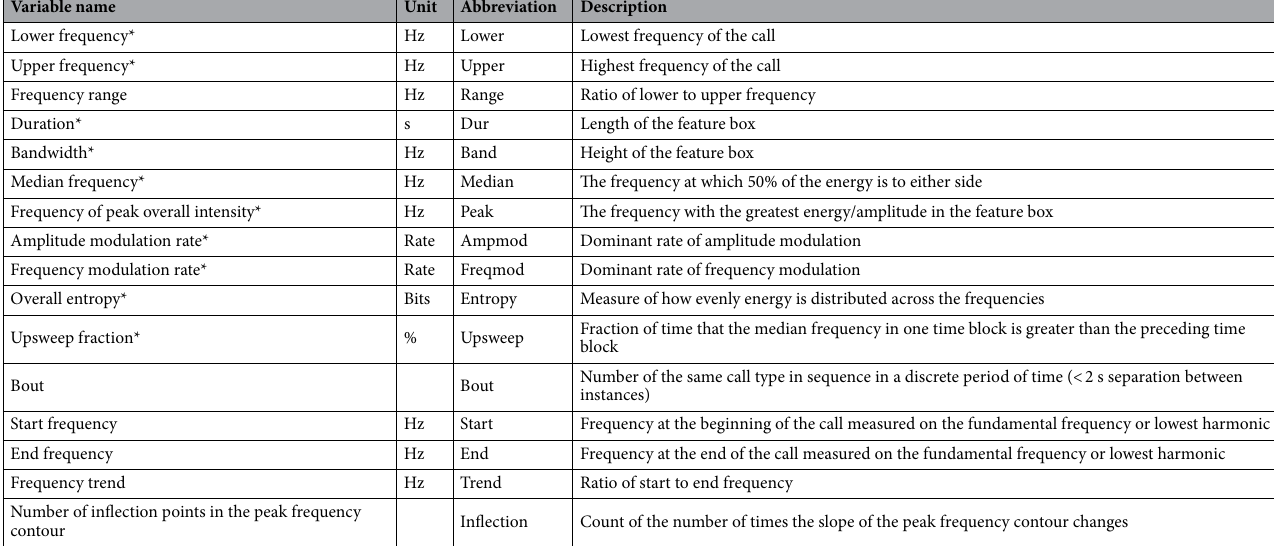
Table 4. Descriptions of the variables that were used in the CART and RF. Variables marked with a * were measured using the Noise-Resistance Feature Set (the same descriptions as for the program Osprey from Mellinger and Bradbury (2007)). The Noise-Resistant Feature Set placed a smaller feature box within the manually created selection box in Raven 1.5 and 2.0. Measurements of the call were made based on the contents of the feature box. Start frequency, end frequency and bout were determined manually in Raven . All frequency variables (i.e. with unit Hz) were log-transformed. Units are provided where applicable. Abbreviations are given for each variable that correspond to the other tables and